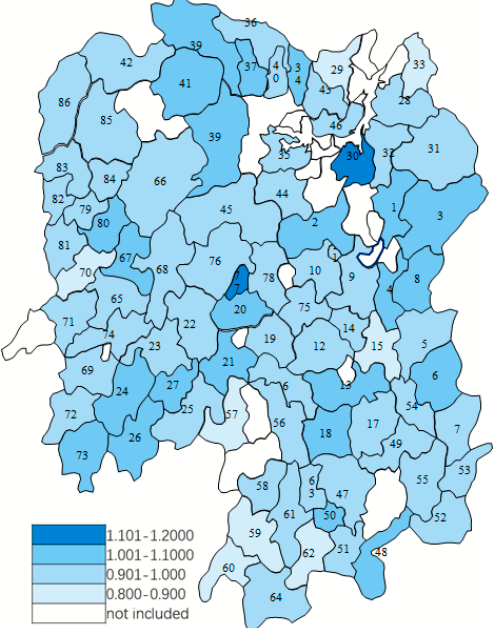
Figure 2. Distribution of factor productivity change (TFP) in 86 counties (county-level cities) from 2009 to 2017.